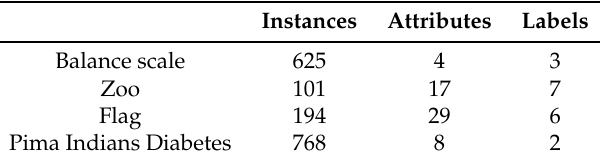
Table 5. The feature of 4 UCI data.